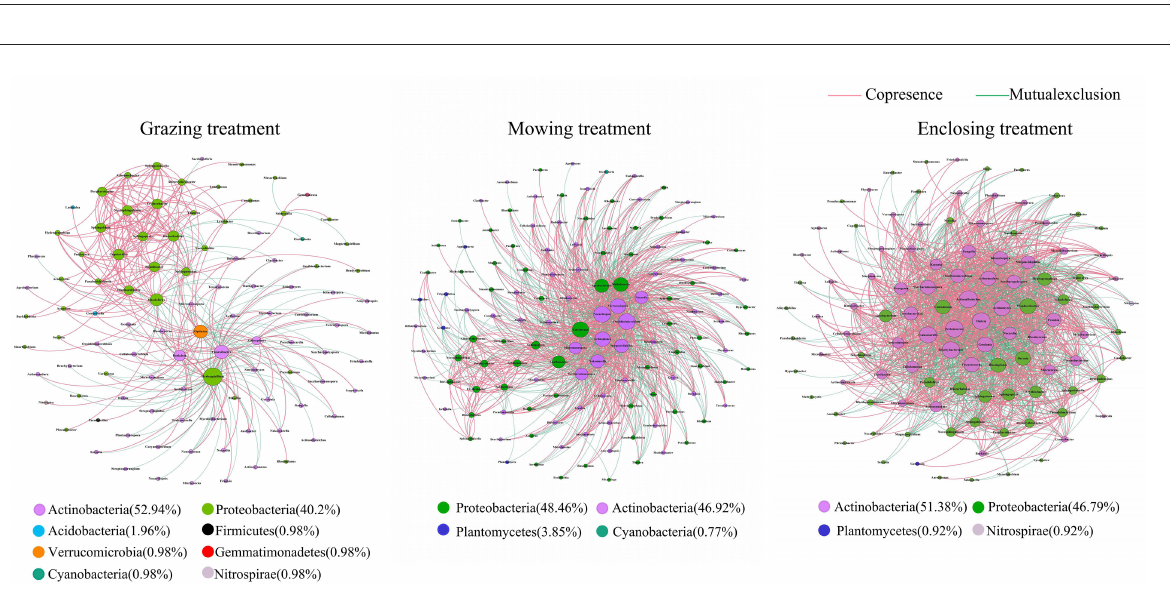
(groups) than differences within a group, but not all differences were significant. Differences in rhizosphere microorganisms among different plant species are expected, but the absence of a significant difference indicates that plant species had a weak effect on rhizosphere microbial communities and cannot be a predominant explanatory factor. A study in